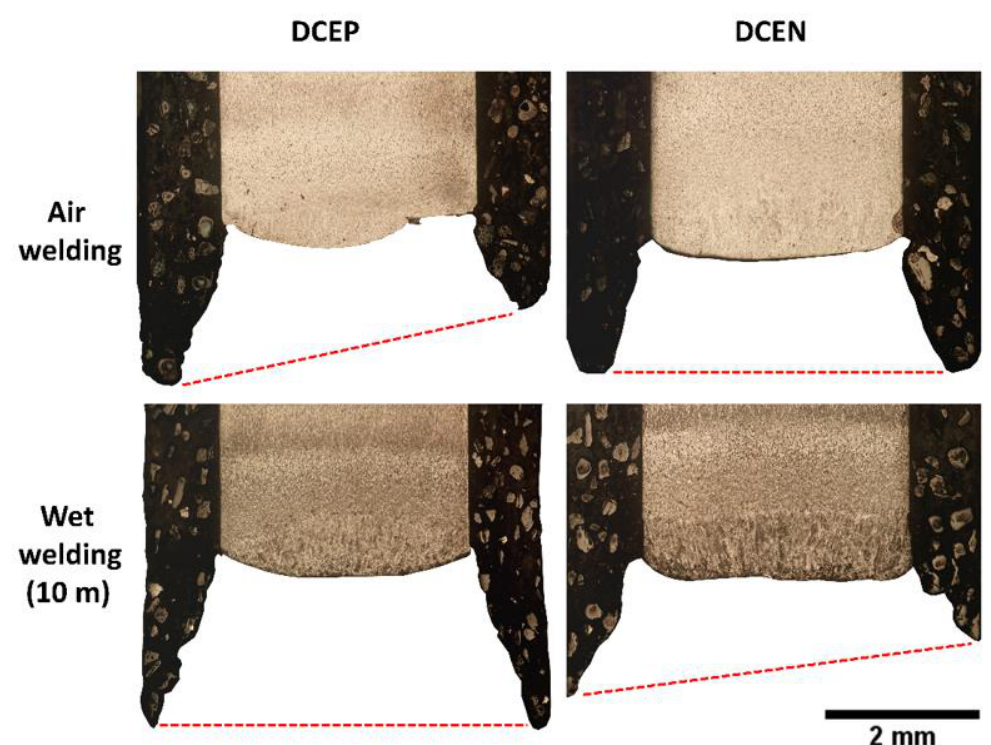
Figure 7. Images of the tips of electrodes showing the arc barrel.